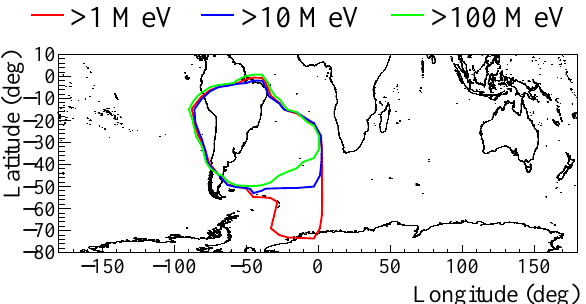
Figure 2. Geographical extension of the SAA for > 1, > 10, and > 100 MeV protons (respectively, blue, red, and green curves in the panel), obtained from the AP9 model.